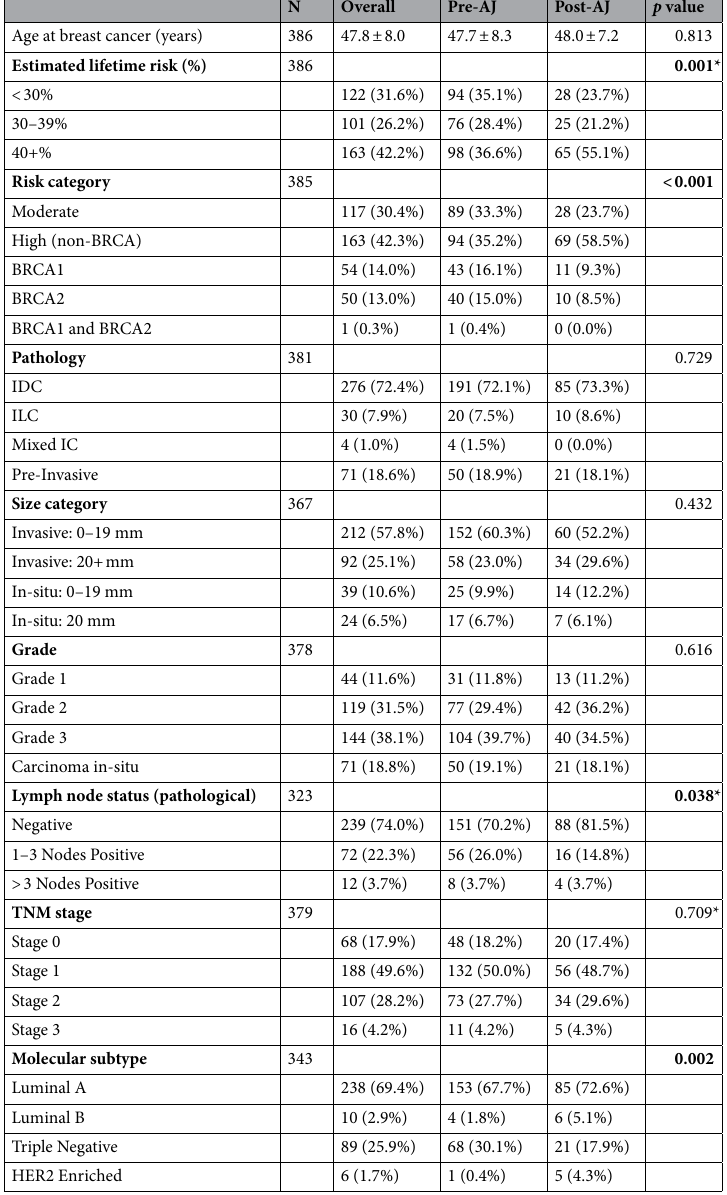
Table 1. Patient demographics. Data are reported as N (column %), with p values from Fisher’s exact tests, or as mean ± SD, with p values from independent samples t-tests, unless stated otherwise. Bold p values are significant at p < 0.05. * p value from Mann–Whitney U test, as the factor is ordinal. IDC invasive ductal carcinoma, ILC invasive lobular carcinoma, IC invasive carcinoma.